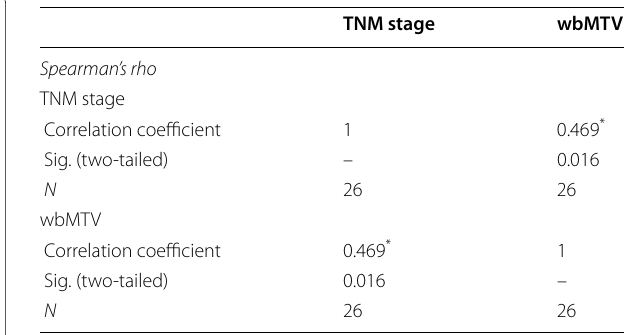
Table.5 Correlation between wbMTV and TNM